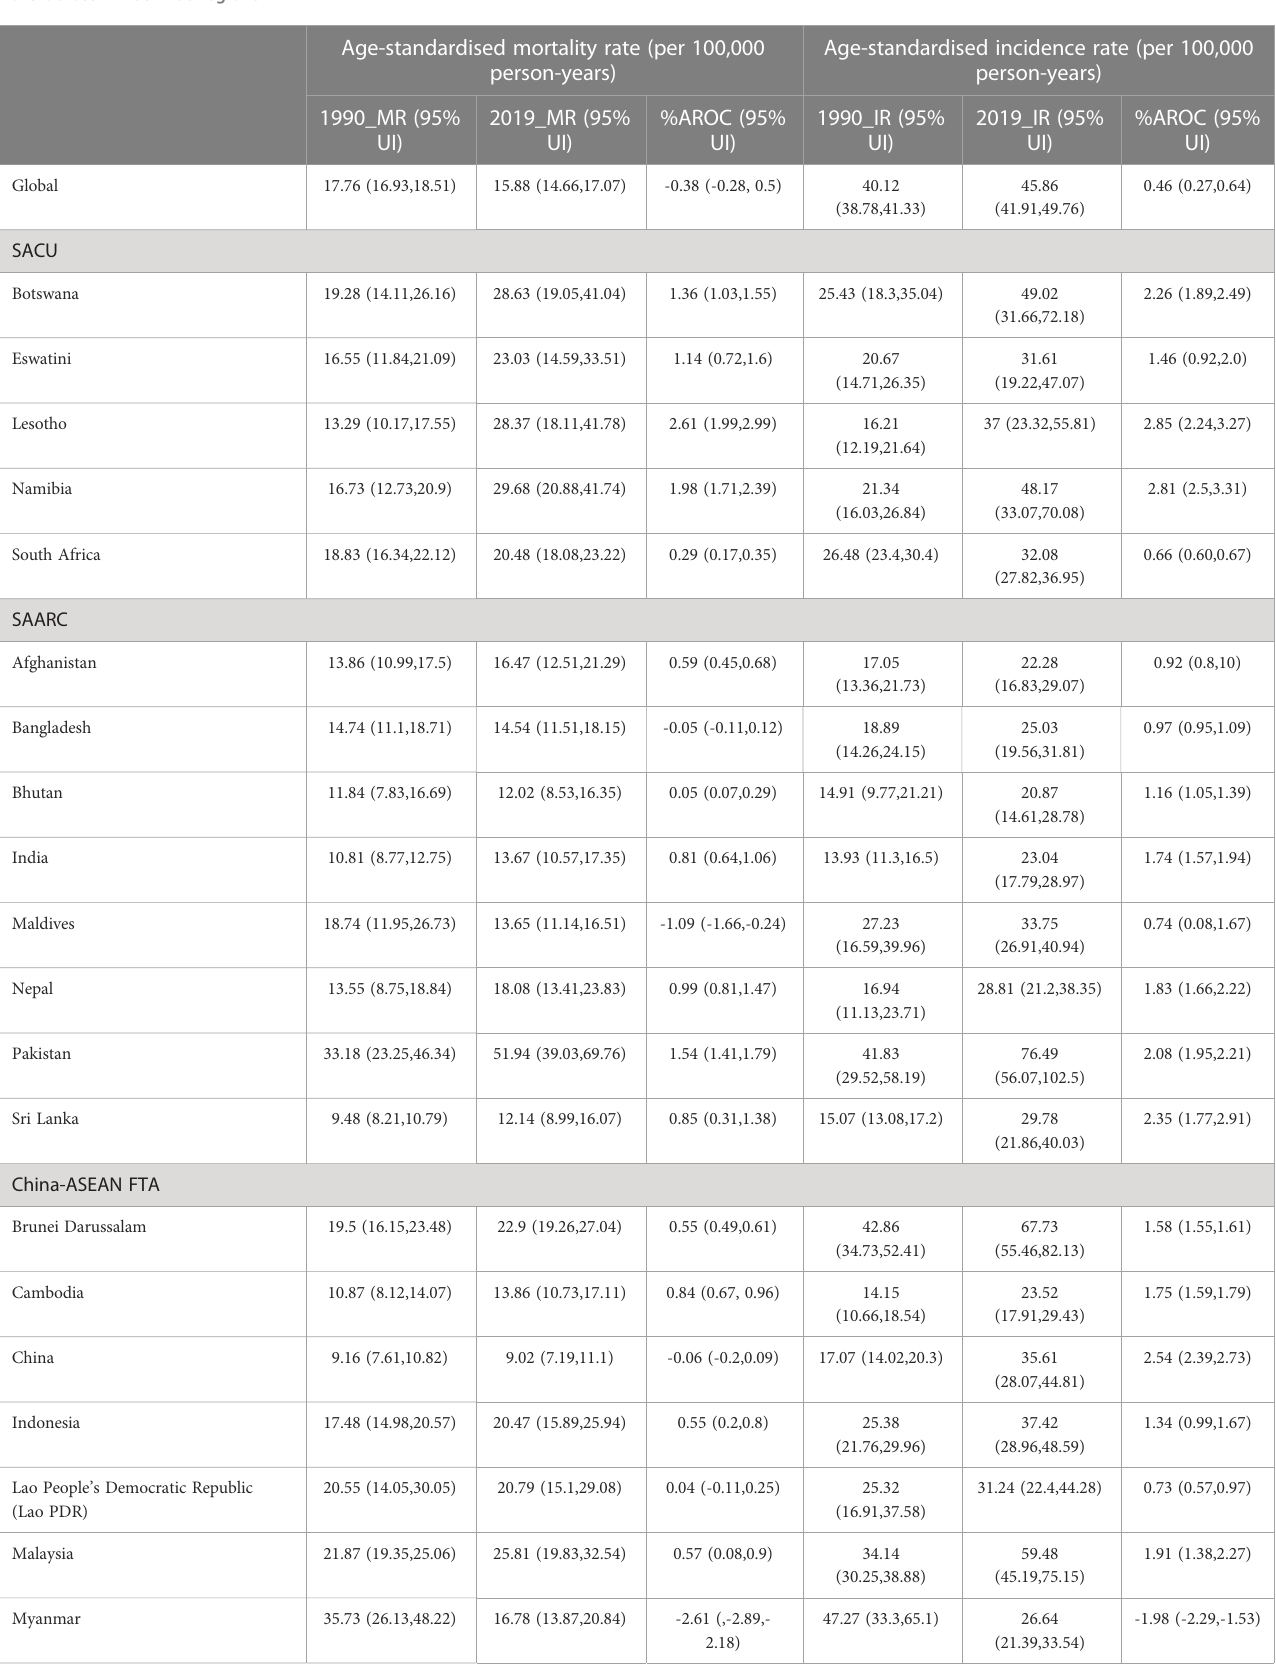
TABLE 1 Age-standardised breast cancer mortality rate and incidence rate (per 100 000 person-years) and Annualized rate of change (AROC%), 1990 to 2019 across BRICS-Plus